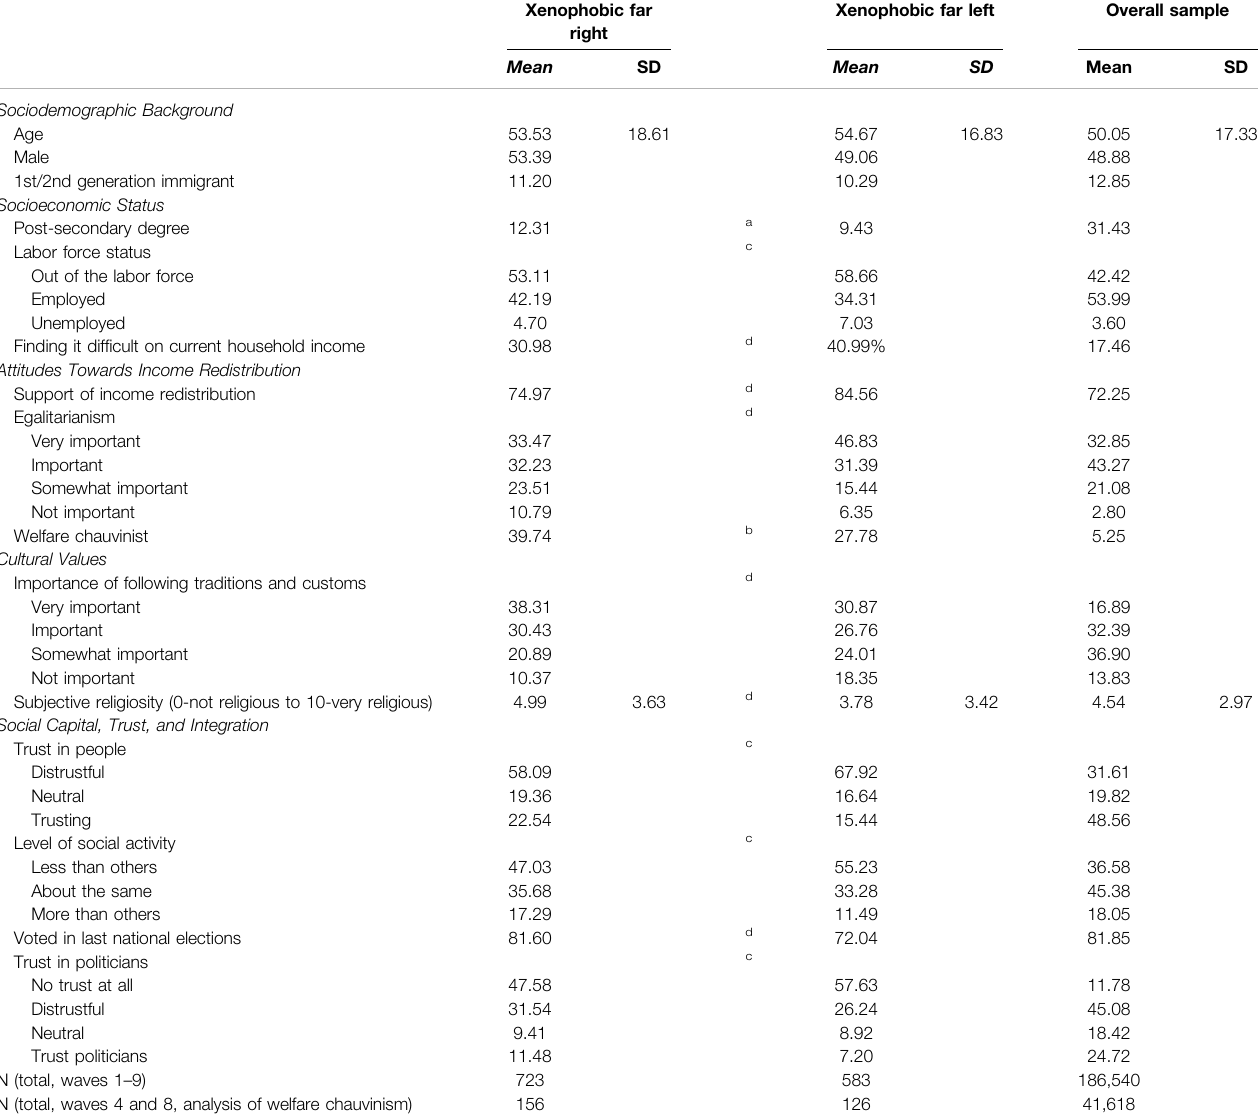
TABLE 1 | Average group characteristics of the extremely xenophobic far right, far left and the overall